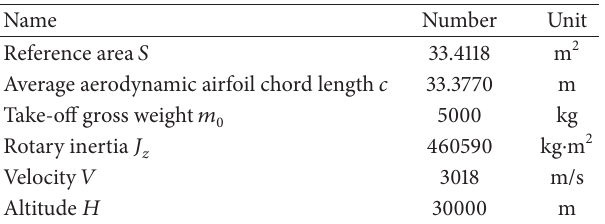
Table 1: The main technical parameters of CSULA-GHV.